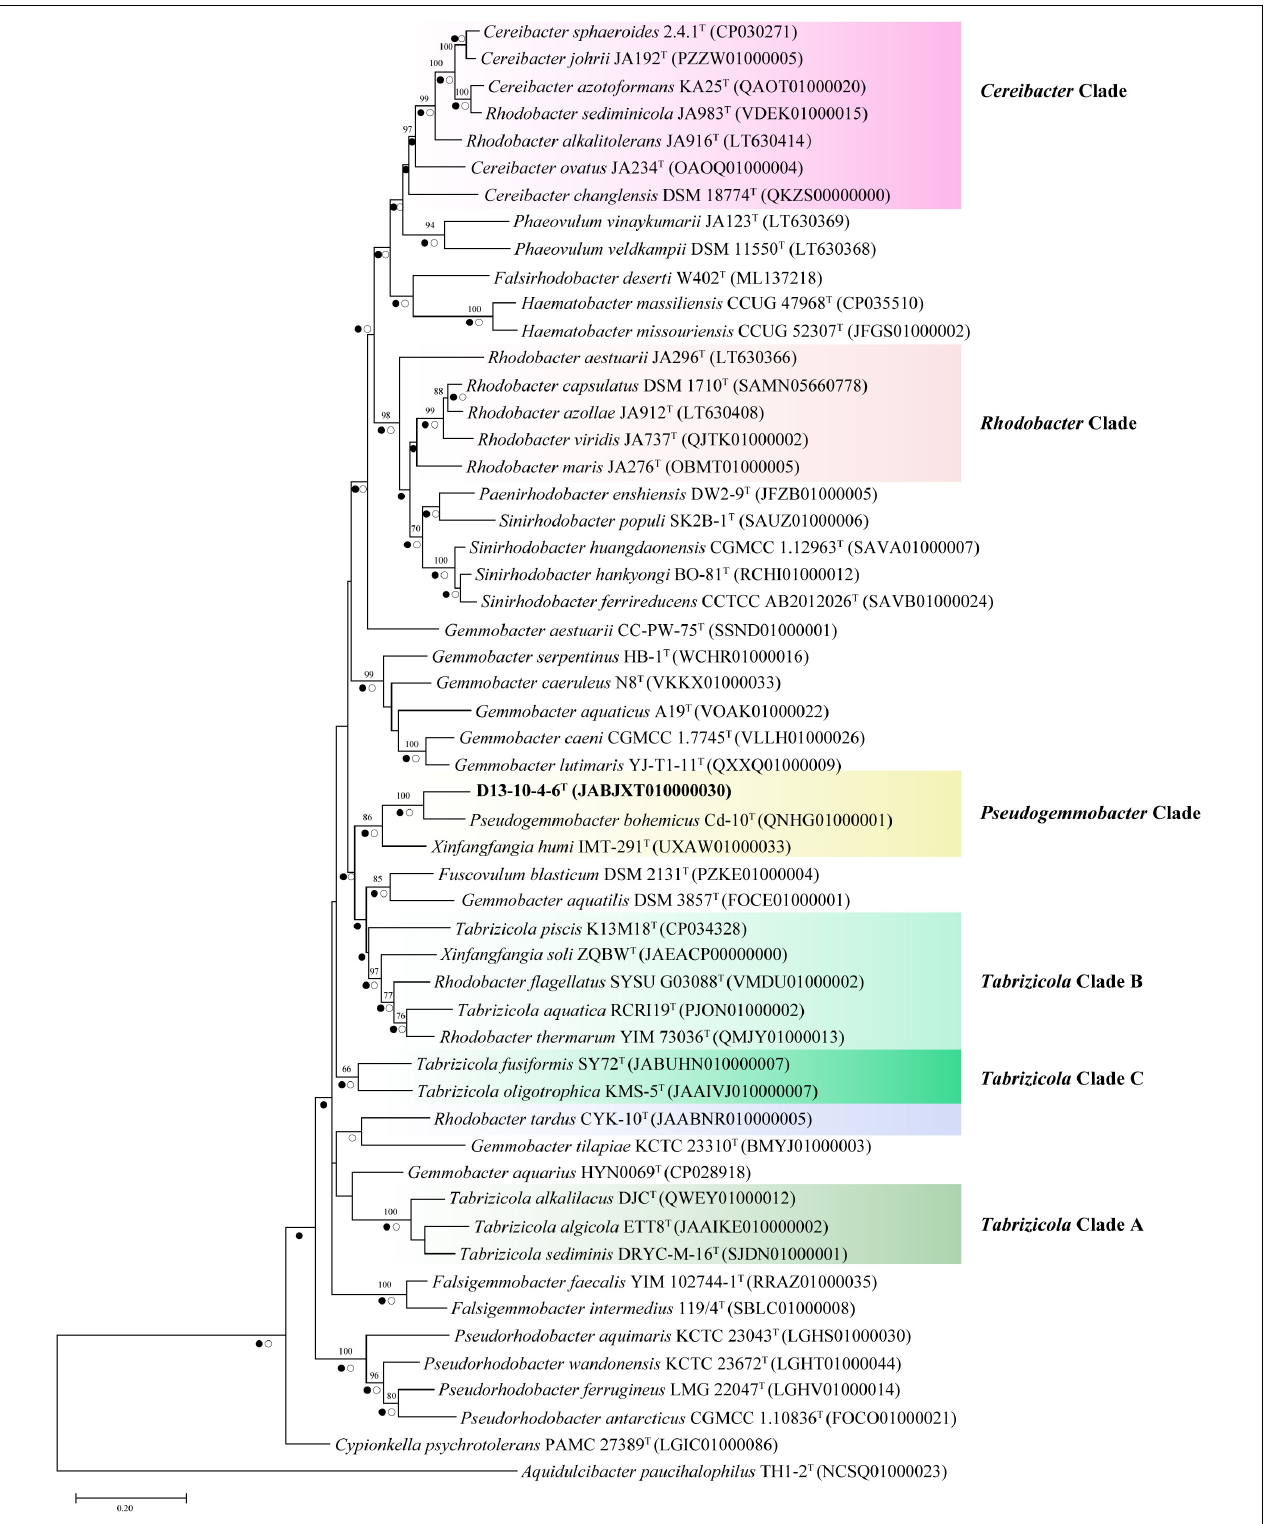
FIGURE 2 | Neighbor-joining phylogenetic trees based on partial gyr B gene sequences showing the position of strain D13-10-4-6 T and reference strains. Bootstrap values over 70% (expressed as percentages of 1,000 replications) are shown. The scale bar corresponds to 0.05 substitutions per nucleotide site. Filled circles indicate branches recovered by maximum-likelihood method and open circles at branches recovered by the maximum-parsimony method.